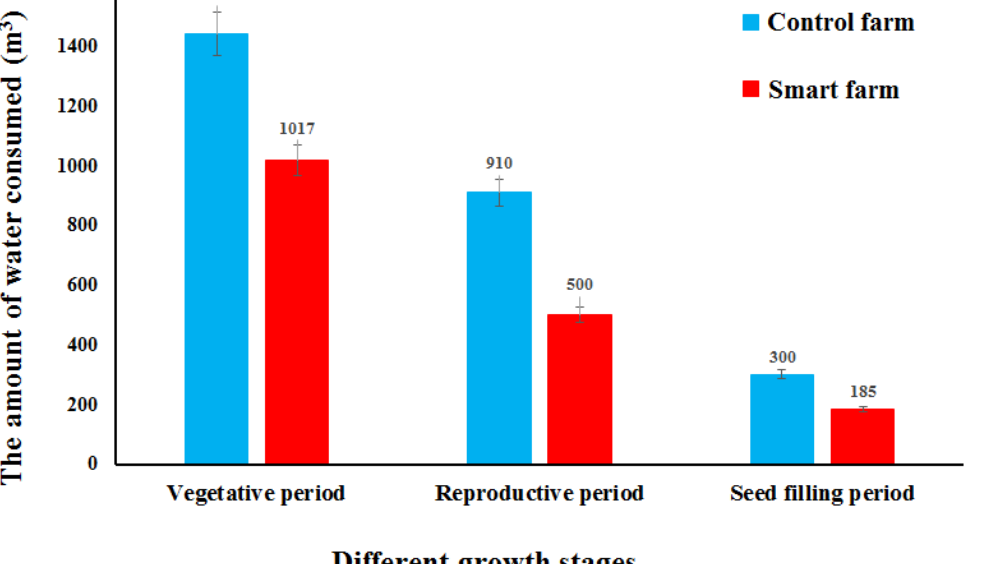
Figure 4. Irrigation water quantity in the three phases of growth, reproduction, and seed maturity.